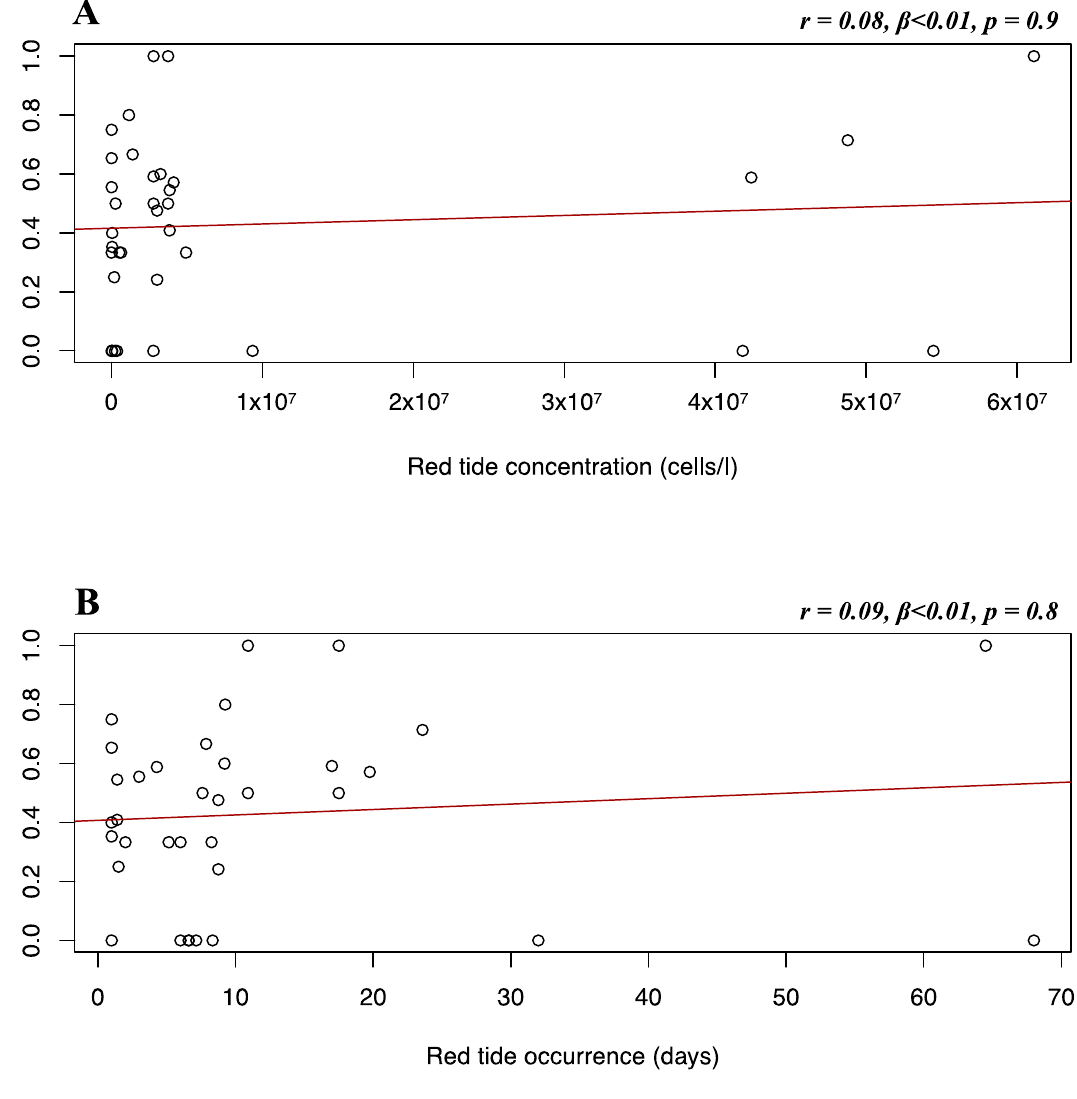
Figure 10. Florida Gulf coast stranded dataset FP prevalence and red tide variables. Scatterplots with fitted regression lines representing the logistic regression output from the response variables versus predictor variables in the Florida Gulf coast stranded dataset: FP prevalence ratio on the y -axis versus red tide concentration ( A ) and red tide occurrence ( B ) on the x -axis. Pearson correlation ( r ), beta-coefficient ( β ), and p -value ( p ) are reported for each predictor variable on the top right of the respective plot.